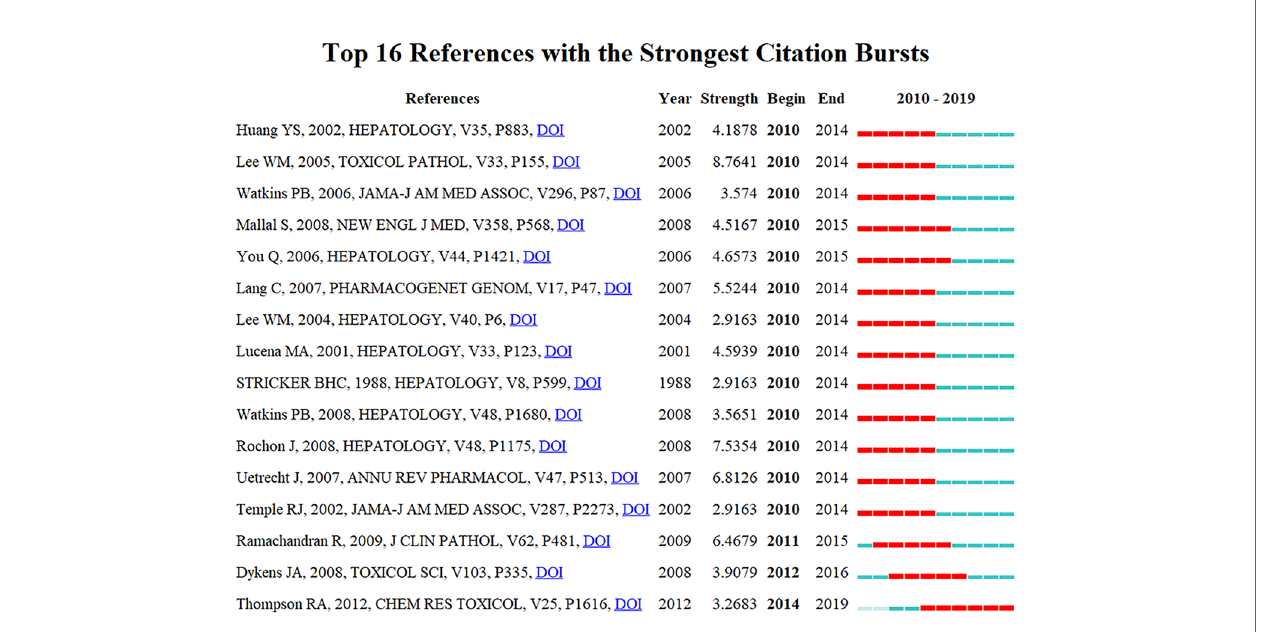
FIGURE 8 | Top 16 references with strong citation burstiness (MD = 5). The red bars mean some references cited frequently; the blue bars were references cited